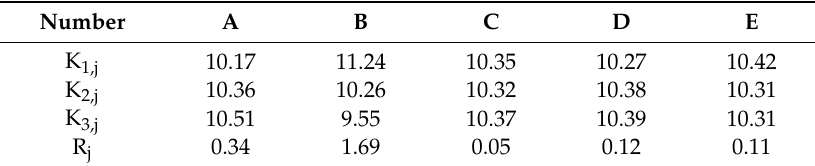
Table 18. Range analysis results of anti-dispersity test.